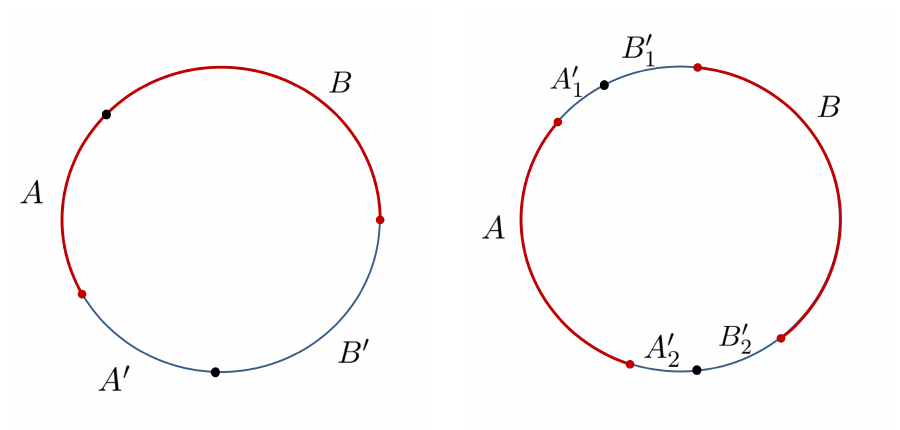
Figure 1: Figures extracted from [ 2 ] , licenced under CC-BY 4.0. The purification of a region AB is given by ABB (cid:48) A (cid:48) for adjacent (left) and non-adjacent (right) intervals. When the intervals are adjacent the auxiliary system A (cid:48) B (cid:48) consists of A (cid:48) B (cid:48) = A (cid:48) ∪ B (cid:48) . In the non-adjacent case, the auxiliary system A (cid:48) B (cid:48) consists of A (cid:48) B (cid:48) = A (cid:48)